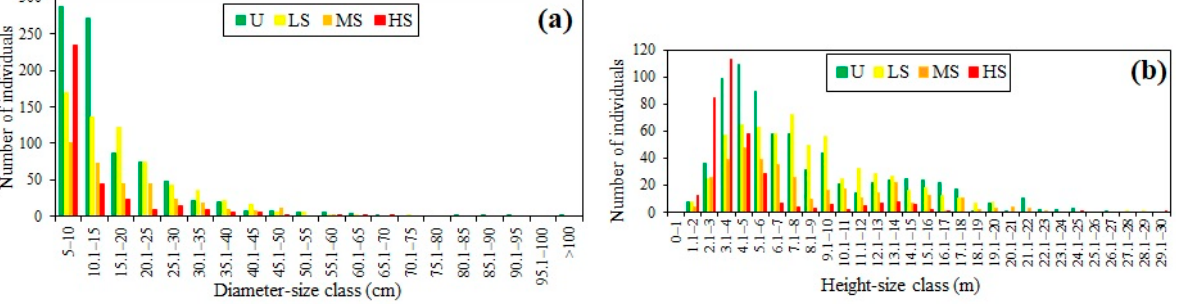
Figure 6. ( a ) Distribution of diameter-size classes across fire severity levels and ( b ) distribution of height classes in each fire severity level.